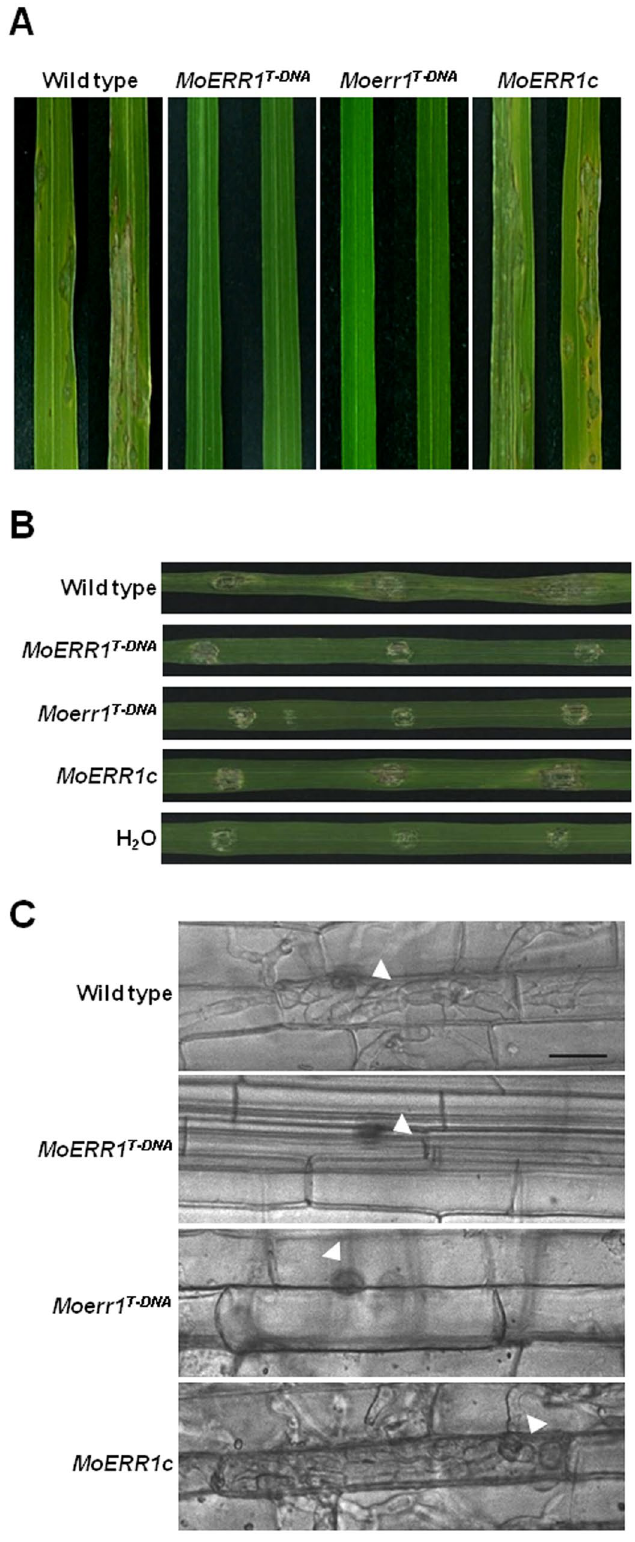
Figure 6. Pathogenicity of wild type and MoERR1 mutants. ( A ) Spray inoculation. Disease symptoms on rice leaves were examined at 7 dpi on susceptible rice cv. Nakdong. ( B ) Infiltration inoculation. Disease symptoms were examined at 7 dpi on artificial wound. ( C ) Rice sheath infection at 48 hpi. Fungal invasive growth in rice sheath cell was observed under light microscopy. Arrows indicate appressorium. Bar = 20 μ